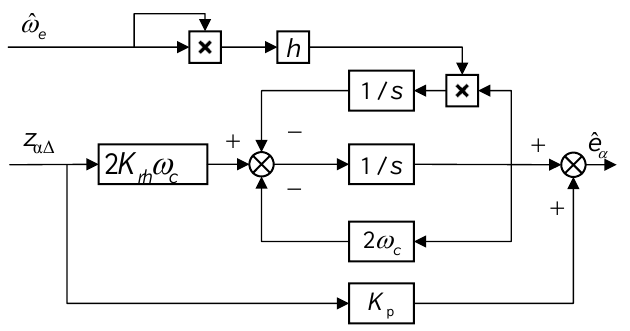
Figure 3. Block diagram of the QPR filter. The parallel connection composed of multiple PR controllers is shown in Figure 4.